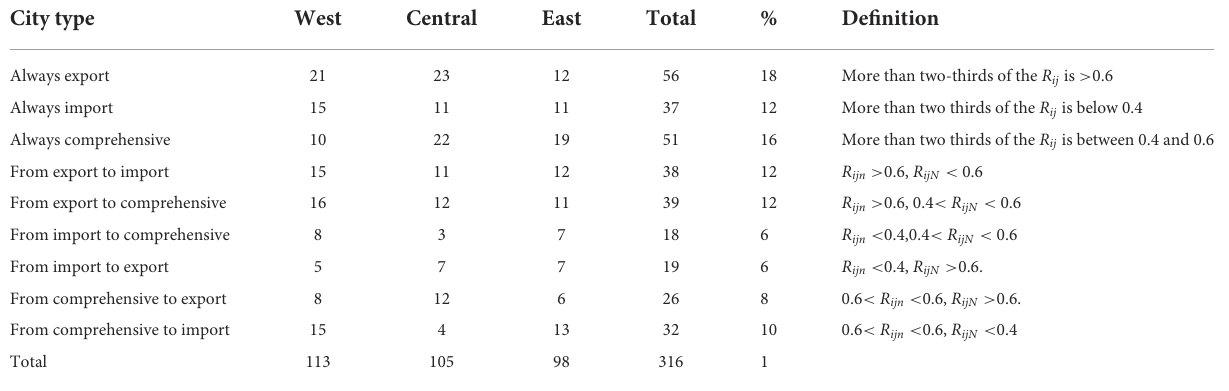
TABLE 2 Evolution of the functions of China’s railway container freight from 2013 to 2020. City